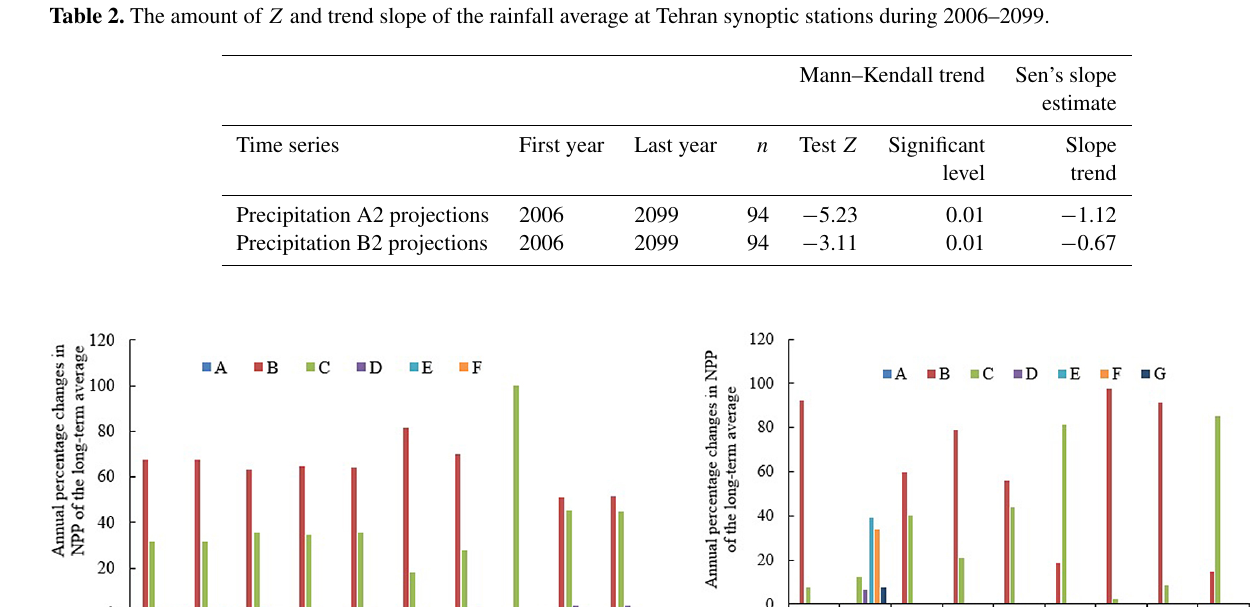
Table 2. The amount of Z and trend slope of the rainfall average at Tehran synoptic stations during 2006–2099.